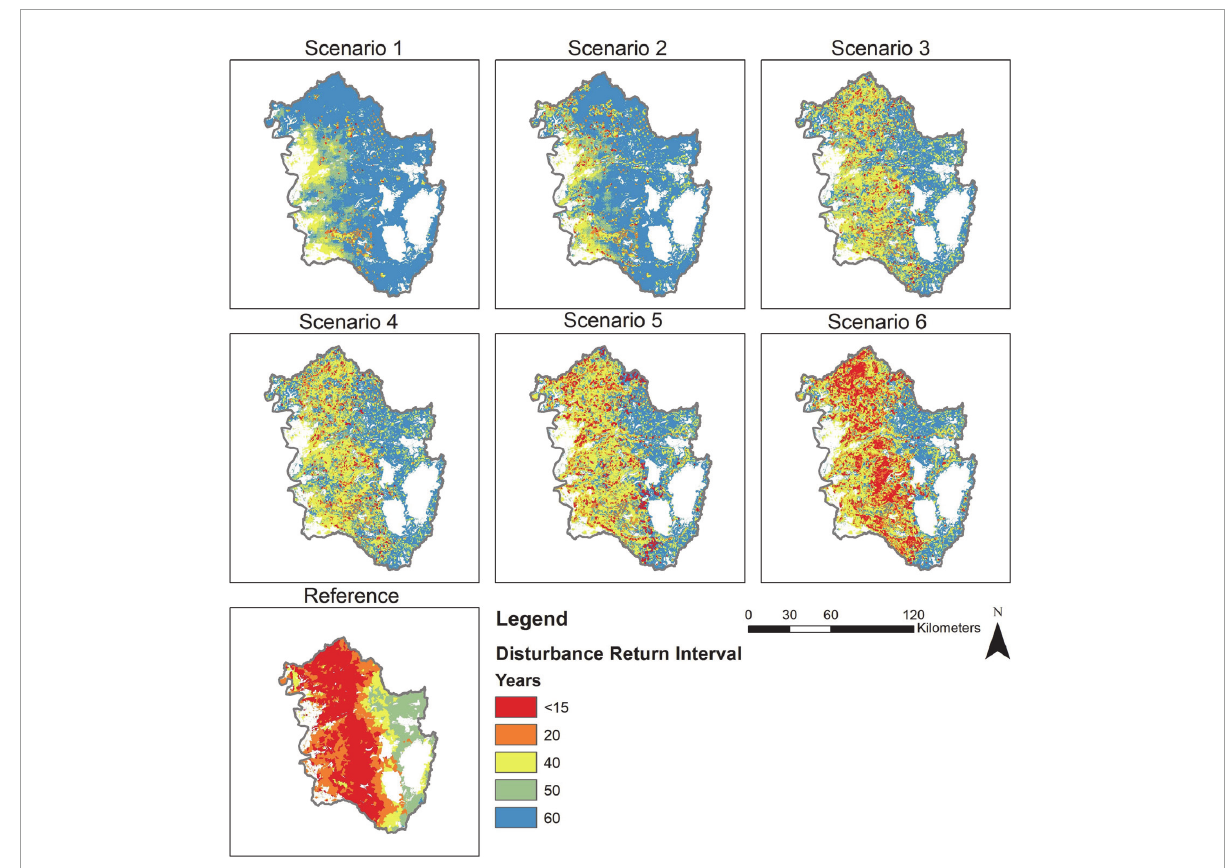
FIGURE2 The frequency of disturbance by management or wildfire (of any severity) over the 2020–2100 time period by scenario averaged over all replicates compared to the reference fire return interval. The disturbance return interval is the number of modeled years (80 years total), divided by the number of disturbances plus one. Only Scenario 6 approaches recreating the reference fire return interval. White areas in the reference map are not available for forest treatment or water